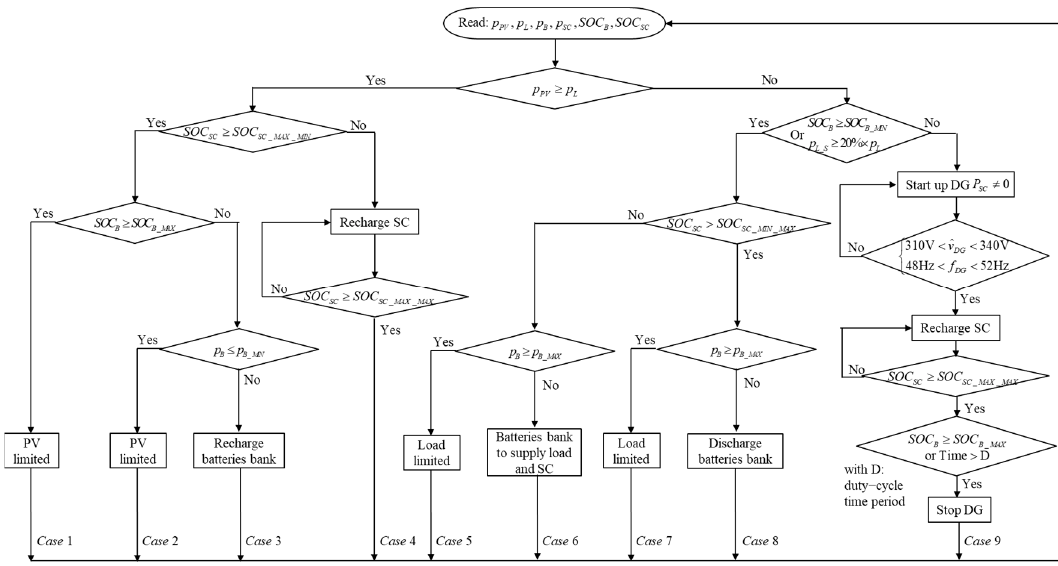
Figure 3. Flow chart of the power management strategy.